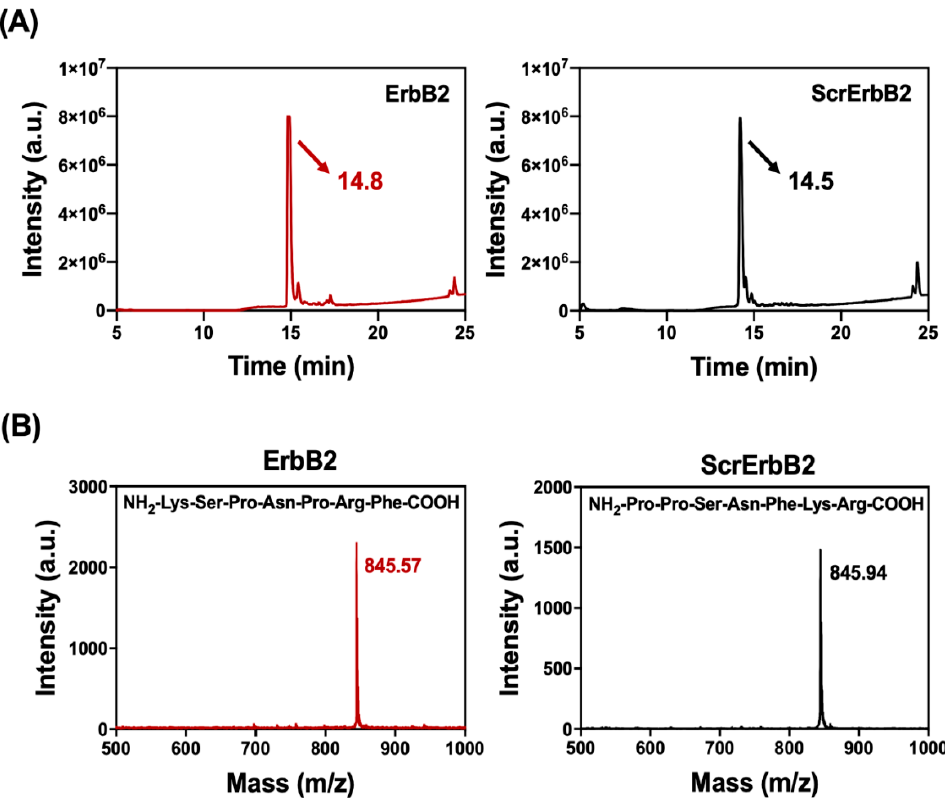
Figure 1. ( A ) The absorbance measured at 220 nm is representative of peptide bonds. A distinct peak confirmed the purity of the peptide synthesized by solid-phase peptide synthesis. The ErbB2 and ScrErbB2 are indicated by arrows. ( B ) Matrix-assisted laser desorption ionization-time-of-flight (MALDI-TOF) mass spectroscopy spectra of purified peptides. Samples were collected at 14–15 min by high-performance liquid chromatography (HPLC). The peaks corresponding to [M + H] + of the peptides ErbB2 (KSPNPRF) and ScrErbB2 (PPSNFKR) had m / z values of 845.57 and 845.94, respectively ( m / z expected: 844.45).